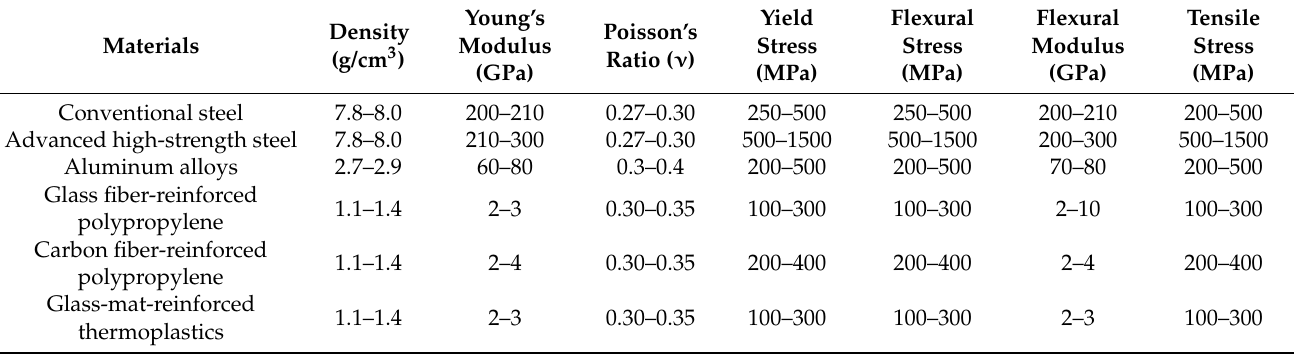
Table 1. The comparison of